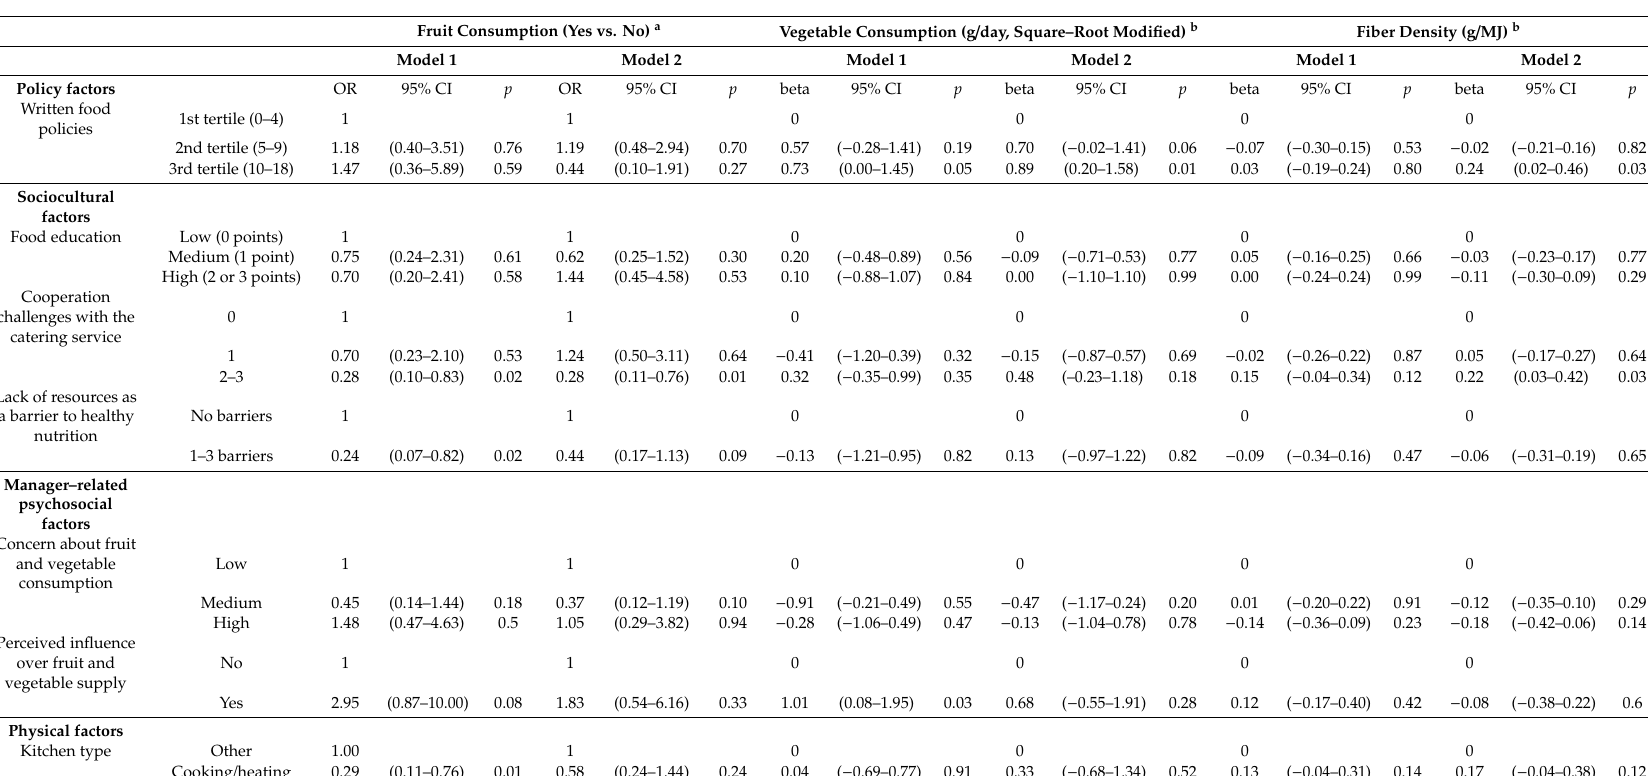
Table 5. Linear and logistic multi-level regression analyses of preschool-level factors and children’s fruit and vegetable consumption, and fibre intake at